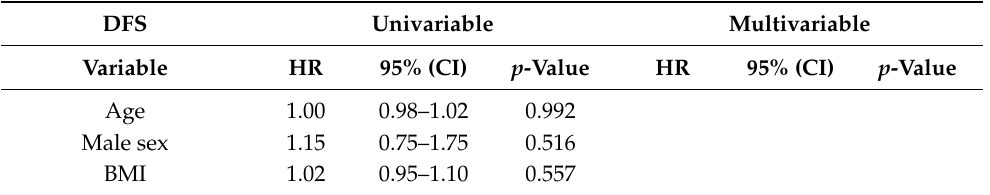
Table 3. Details of the statistical analyses: univariate and multivariate analyses for disease-free survival (Cox proportional hazards